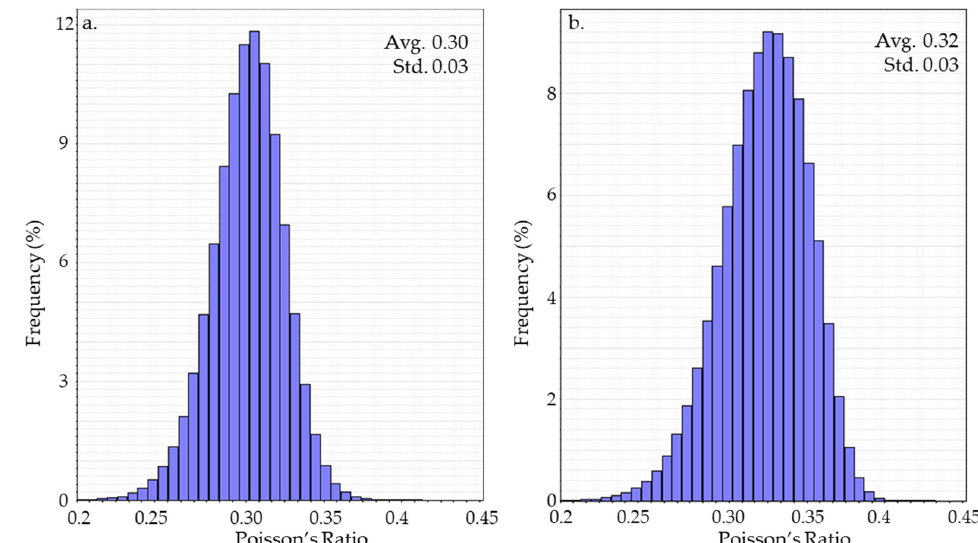
Figure 5. Poisson’s ratio property estimated using inverted impedance volume is distributed in the upper ( a ) and lower ( b ) Drake unit. The standard deviation and average values for each unit are also shown.